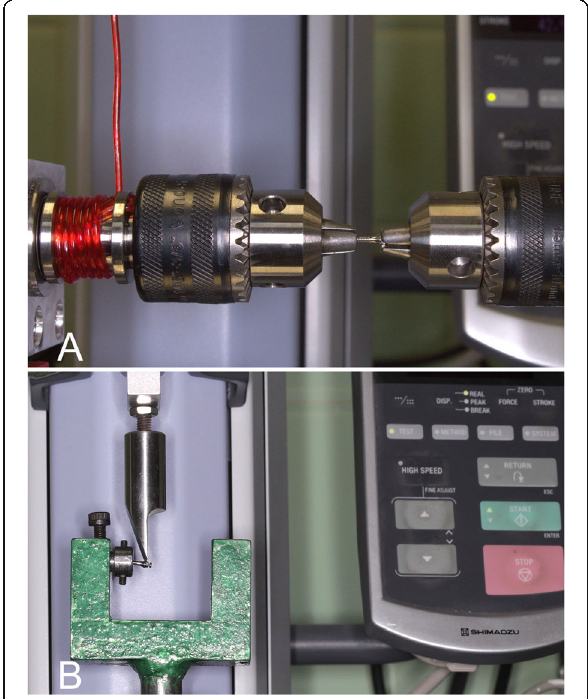
Fig. 3 Custom-fabricated devices. Torsional ( a ) and flexural ( b ) tests using a mechanical testing machine (EZ-SX/Shimadzu, Barueri, SP, Brazil) with a 500 N load